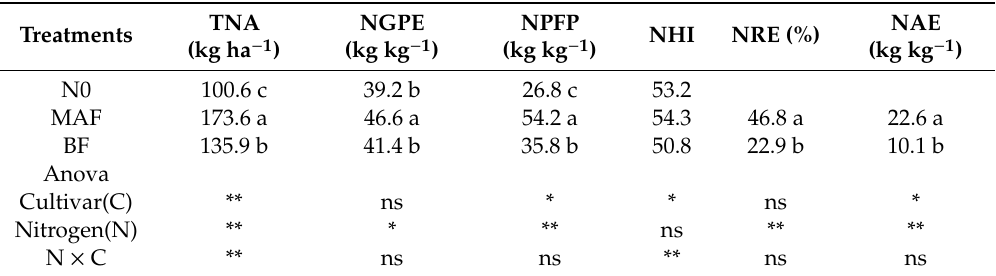
Table 2. E ff ects of mechanical deep placement of nitrogen fertilizer on average nitrogen use e ffi ciency for both rice cultivars in two-year (2018 and 2019).